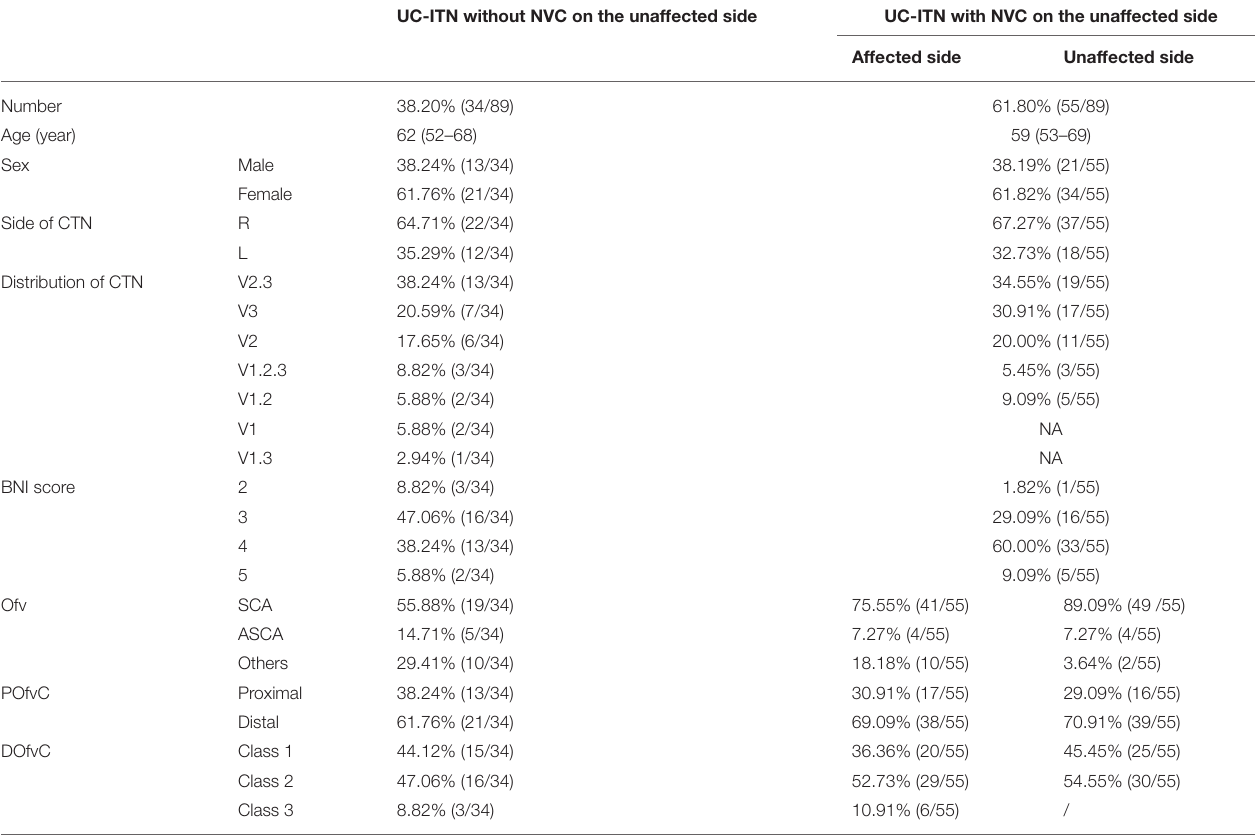
TABLE 1 | Demographic and clinical characteristics of patients with